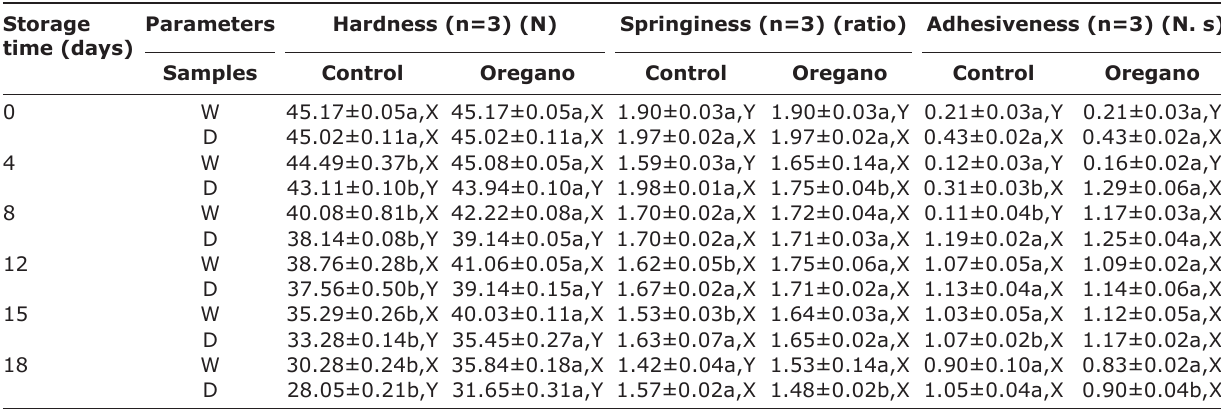
Table-4: Effect of oregano extract with vacuum packaging on the hardness, the springiness and the adhesiveness of white (W) and dark (D) muscles of frigate tuna fillets stored at refrigerated (3±1°C) conditions. Storage Parameters time (days)